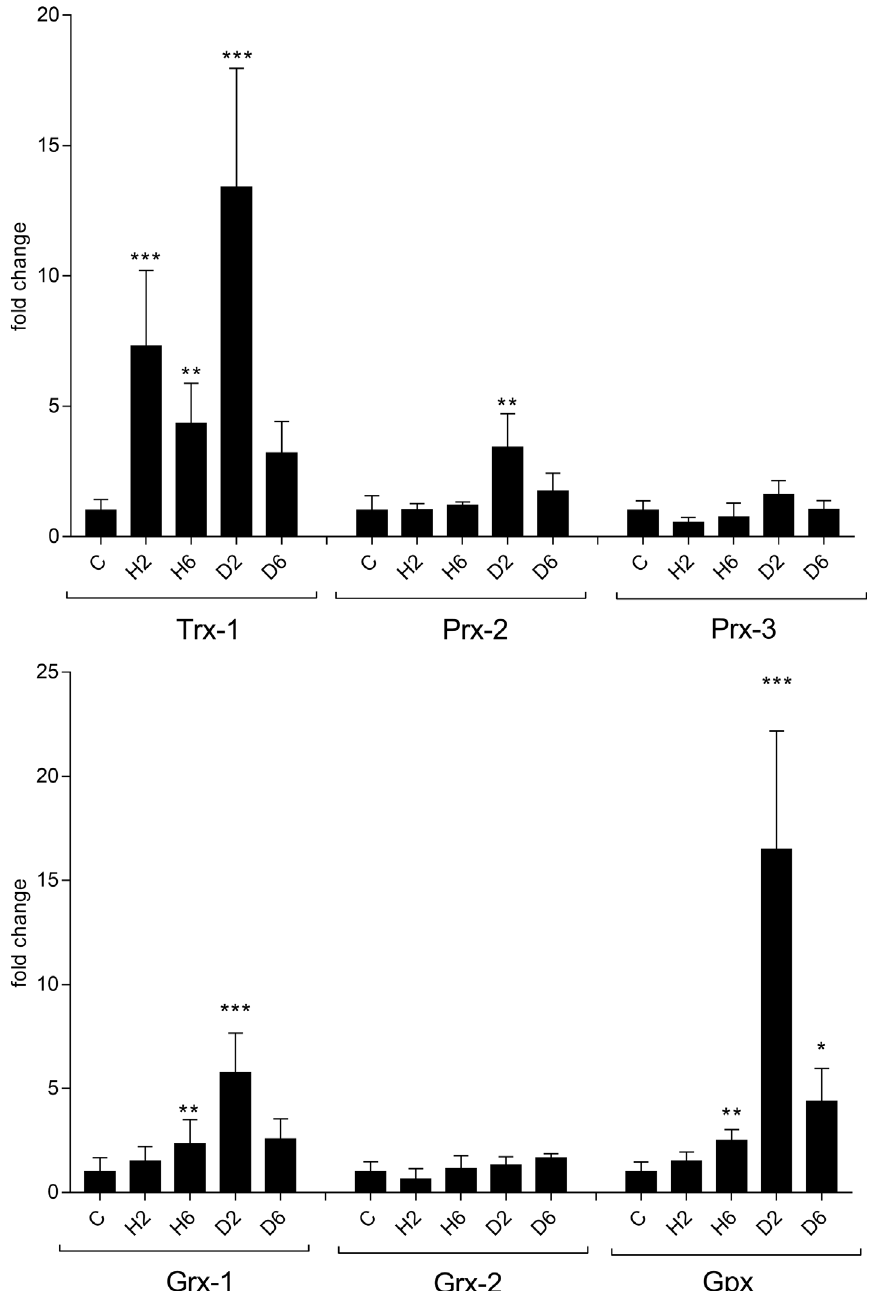
Figure 1. RNA expression of investigated target genes in A. castellanii strain Neff after challenge with 750 l M H 2 O 2 for two (H2) and six (H6) hours and 2 mM diamide for two (D2) and six (D6) hours. (a) Thioredoxin 1 (Trx-1), peroxiredoxin 2 (Prx-2), peroxiredoxin 3 (Prx-3). (b) Glutaredoxin 1 (Grx-1), glutaredoxin 2 (Grx-2), glutathione peroxidase (Gpx); C: untreated control. The y -axis indicates – fold increase of RNA levels as compared to untreated controls. Error bars show the standard deviation of the mean (SEM). All values were obtained from at least three biological replicates in triplicate. * p < 0.05, ** p < 0.01, and *** p < 0.0001 according to statistical analysis (multiple comparisons with a Kruskal – Wallis test on ranks followed by Dunn ’ s post hoc